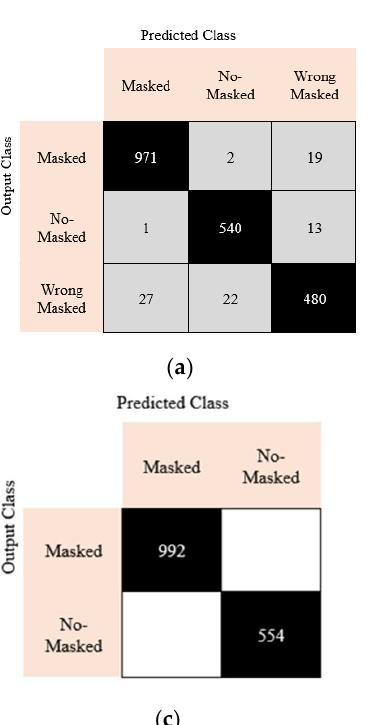
Figure 6 communicates the classification results in the form of a confusion matrix for each of the three cases.